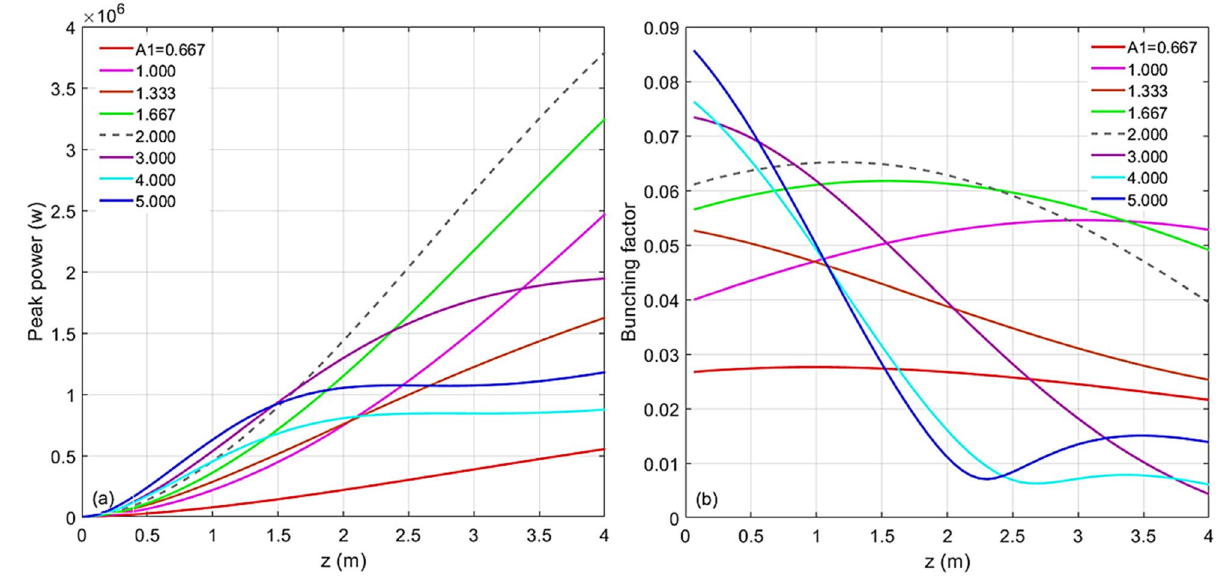
Figure 7. For the case of harmonic 183, the energy modulation of stage 1 is scanned with the values of 0.667 (red), 1.000 (magenta), 1.333 (orange), 1.667 (green), 2.000 (grey), 3.000 (purple), 4.000 (cyan), and 5.000 (blue). ( a ) Peak power versus undulator position. ( b ) Bunching versus undulator position.